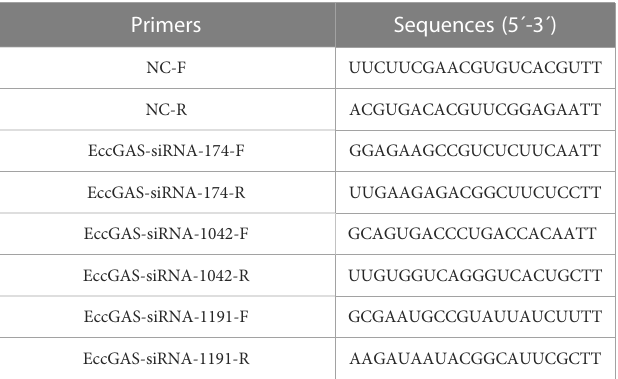
TABLE 2 Primers used for silencing